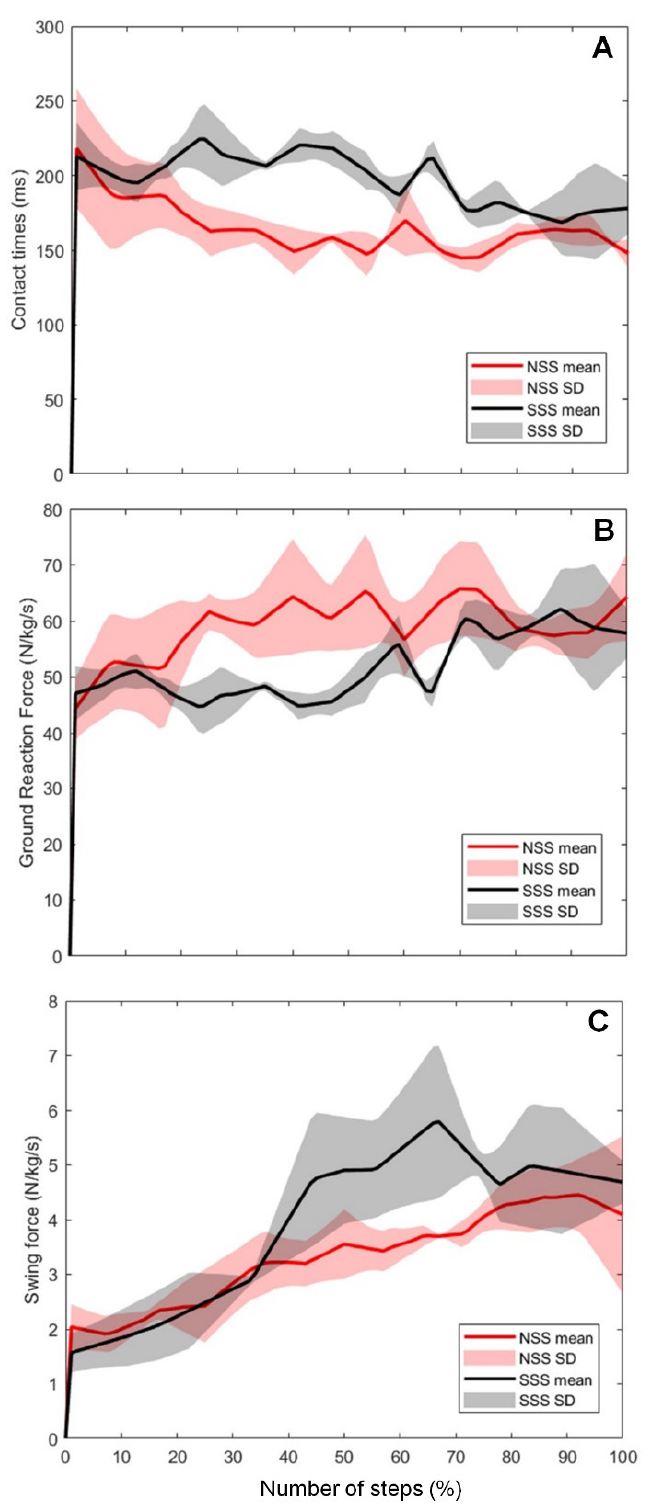
Figure 4. Average trend of contact time ( A ), vertical ground reaction force rate ( B ), and swing force rate ( C ) during the running trials. The number of steps of the trials was normalized on a 0–100% scale to compare the different curves by plotting the scalar field of each running trial. NSS: normal spike shoes, SSS: super spike shoes.